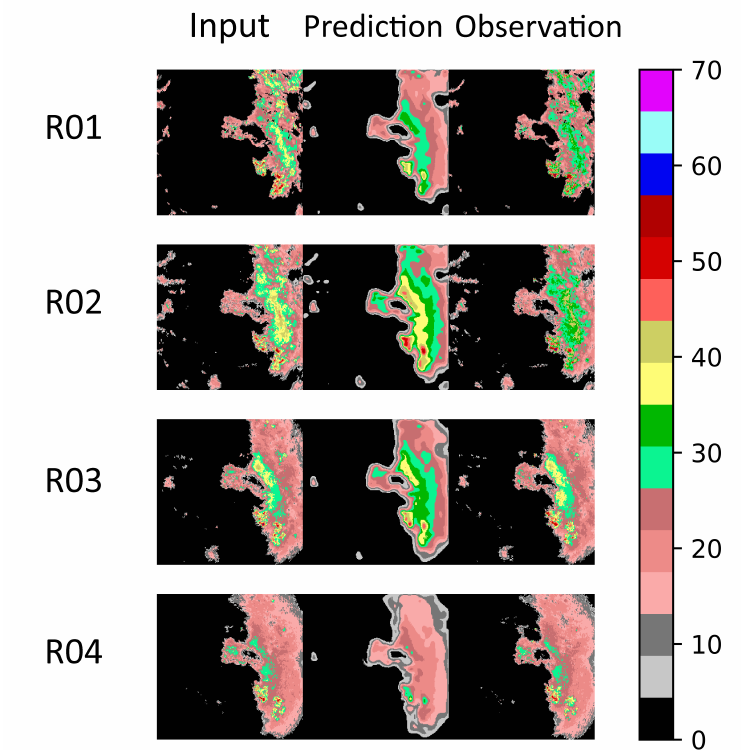
Figure 9. Sample predictions from our model that was trained using the NMA dataset. The first column depicts the inputs, the second column presents the predictions and the last column shows the ground truth observations. Each row shows a different product (R01 to R04). The illustrated observations and predictions correspond to radar measurements that were gathered in an area of approximately 250 × 250